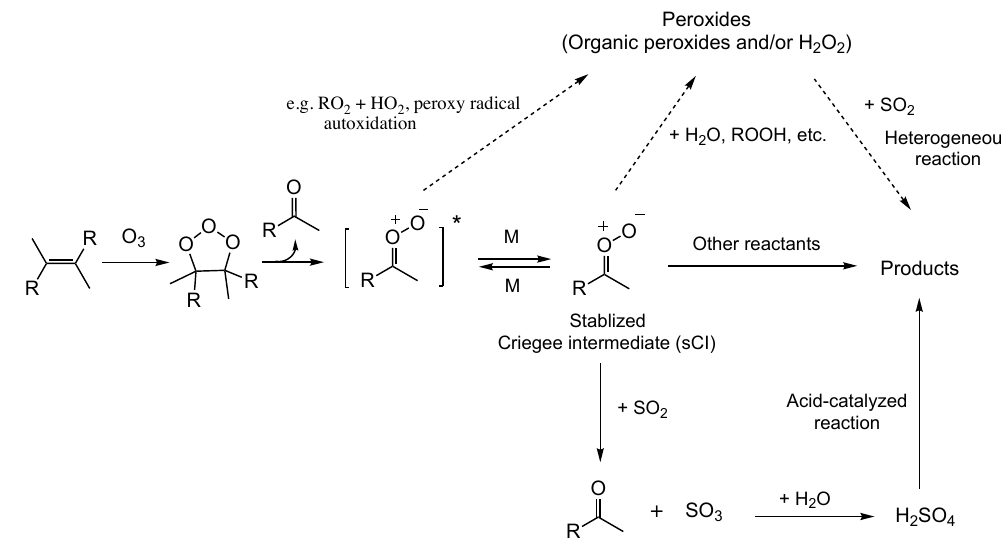
Scheme 2. Proposed reaction mechanisms for SO 2 and reactive intermediates in monoterpene